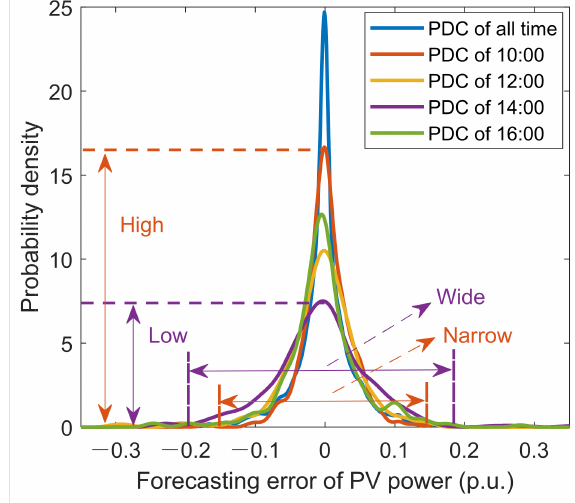
Figure 5. Probability density curves of different periods.